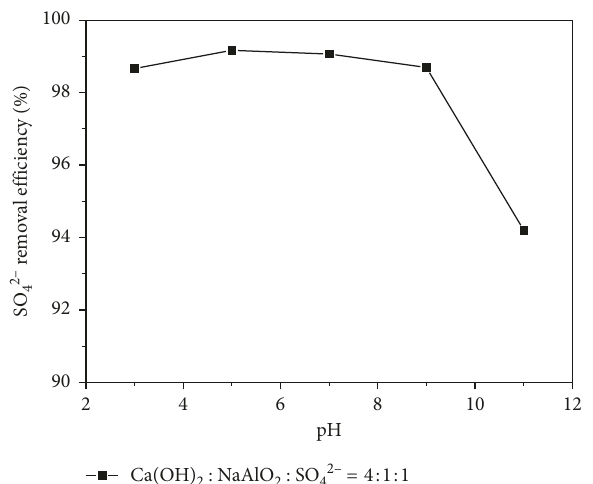
Figure 3: The effect of the solution initial pH. v 200r/min, and t T 25 ° C, v (cid:27) (cid:27)